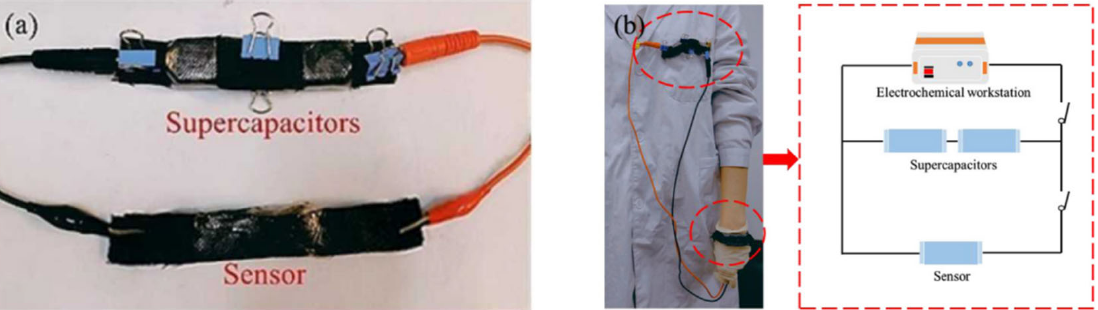
Figure 12. ( a ) Schematic diagram of the sensor system; ( b ) The flexible sensing system includes a supercapacitor placed on the surface of the coating and a sensor attached to the skin, as well as a schematic diagram of the complete circuit. Reprinted with permission from Ref. [11]. Copyright 2022, Elsevier.